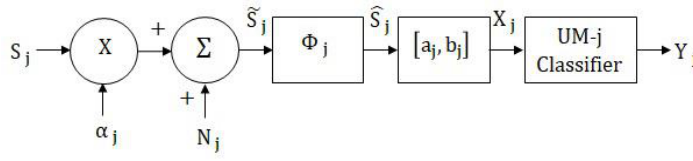
Figure 2. Block diagram of the unimodal classification system for modality j.